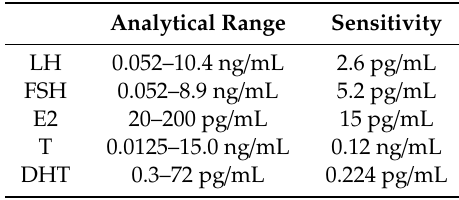
Table 1. Analytical ranges and sensitivities of methods used to determine